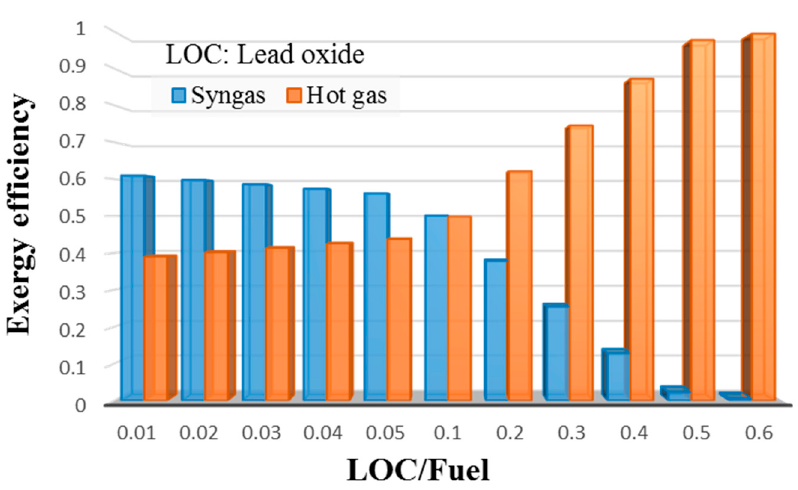
Figure 11. Exergy e ffi ciency for LCLG working with liquid lead Figure 11. Exergy efficiency for LCLG working with liquid lead oxide.